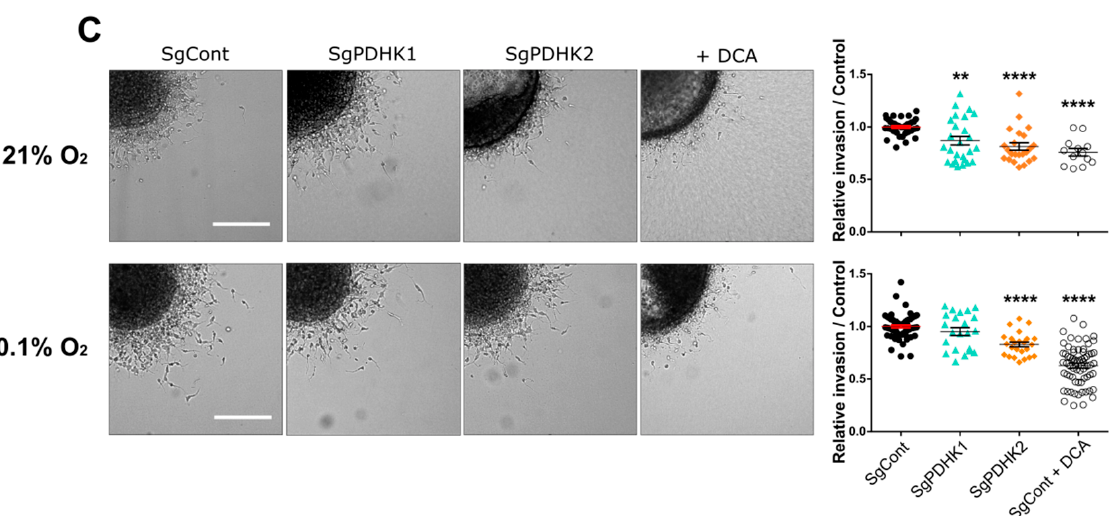
Figure 4. Genetic or pharmacologic PDHK disruption impairs GB cell proliferation and invasion. ( A ) Left panel : P3 spheroid growth recorded over 7 days in normoxic conditions (21% O 2 , 8–12 spheroids per condition, n = 3). Statistics versus control condition are presented in the table. Right panel : the same experiment was processed in hypoxic condition (0.1% O 2 ). ( B ) Evaluation of live/dead cell status of spheroids exposed to both hypoxic conditions and DCA treatment. Upper panel : brightfield image of P3 SgCont spheroid before and after being exposed to vehicle or DCA 25 mM treatment for 7 days (left: vehicle; right: DCA). Middle and lower panels : viability assessment of spheroids, incubated with calcein (green) and ethidium homodimer (red), after a 7-day DCA or vehi- cle treatment. Scale bar: 150 µ m. ( C ) Left panel : representative images of invasive spheroids SgCont, SgPDHK1, SgPDHK2 or treated with DCA, included in a collagen I matrix and incubated either at 21% or 0.1% O 2 for 24 h. Scale bar: 150 µ m. Right panel : relative invasion rate compared with the control condition (8–10 spheroids per condition, n = 3 to 5) upon 21% or 0.1% O 2 exposure. Data are expressed as the mean ± SEM, and p-values were obtained using two-way ANOVA ( A , C ); * p < 0.05; ** p < 0.01; *** p < 0.001; **** p < 0.0001; ns. : not significant; nd. : not